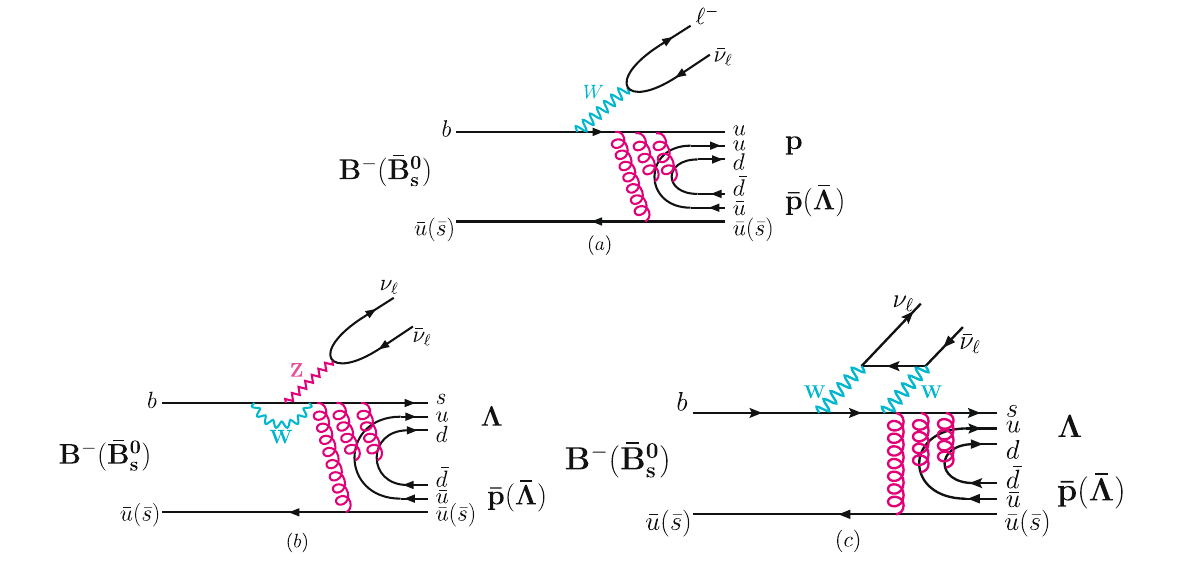
Fig. 1 Feynman diagrams for the B → B ¯ B (cid:3) L ¯ L (cid:3) decays, where ( a ) depicts B − → p ¯ p (cid:9) − ¯ ν (cid:9) and ¯ B 0 s → p ¯ (cid:3)(cid:9) − ¯ ν (cid:9) , while ( b , c ) B − → (cid:3) ¯ p ν (cid:9) ¯ ν (cid:9) and ¯ B 0 → (cid:3) ¯ (cid:3)ν (cid:9) ¯ ν s